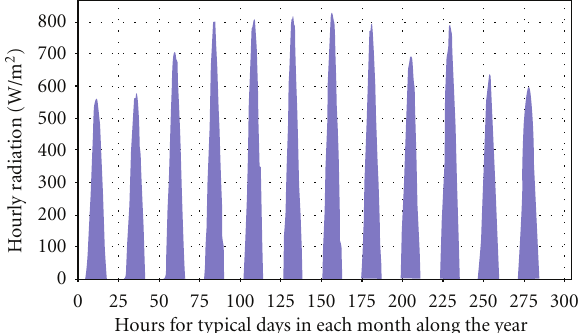
Figure 12: The monthly average hourly radiation based on the ref- erence year.